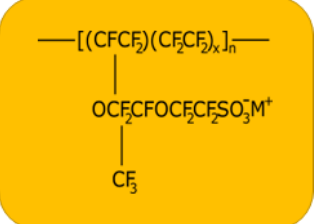
Figure 1. The chemical structure of the used Nafion membrane-N117 where x = 6.5, and M + stands for an exchangeable counterion.